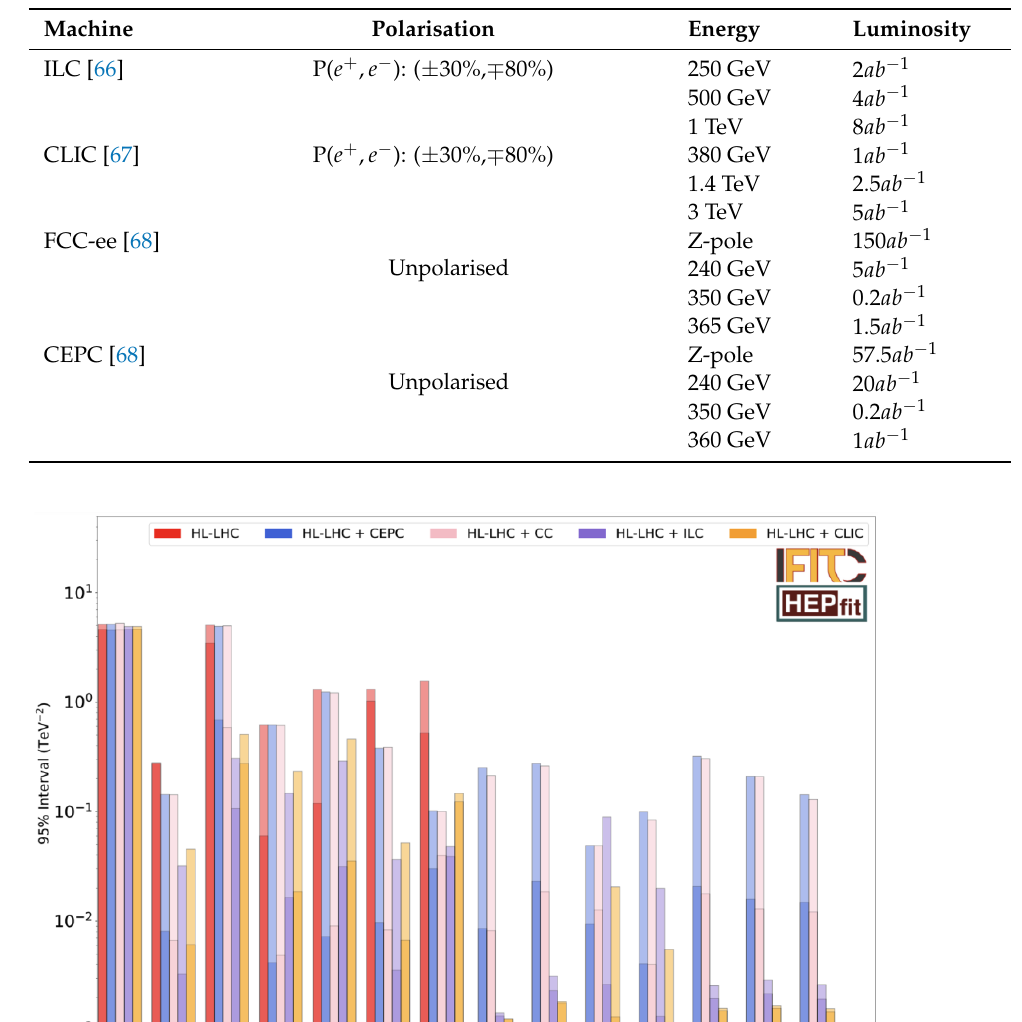
Table 4. Table of the working configurations for several future e + e − colliders from Ref. [59]. The machines listed in the table are: the International Linear Collider (ILC), the Circular Electron–Positron Collider (CEPC), the Compact Linear Collider (CLIC) and the Future Circular Lepton Collider (FCC- ee). The polarisation, energy and luminosity for 3 to 4 different running stages are listed along with references to the relevant documentation.